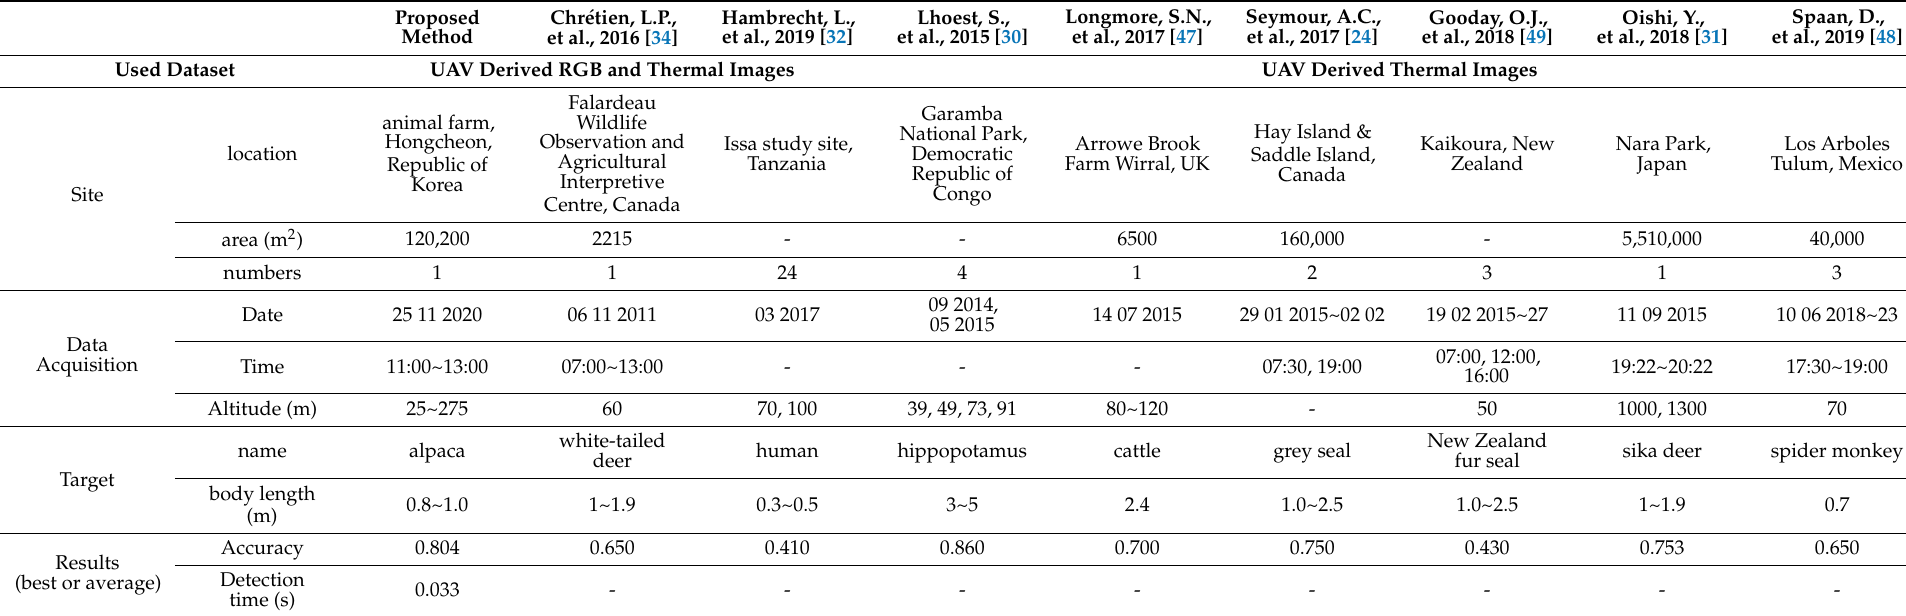
Table 3. Comparison of the proposed method with previous